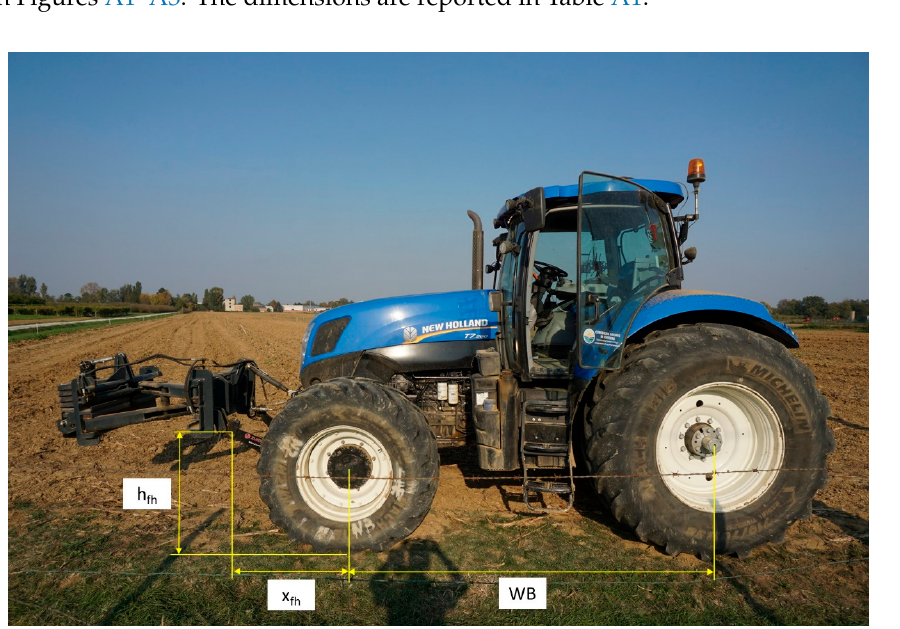
Figure A1. Tractor dimensions in FC and FE configurations.